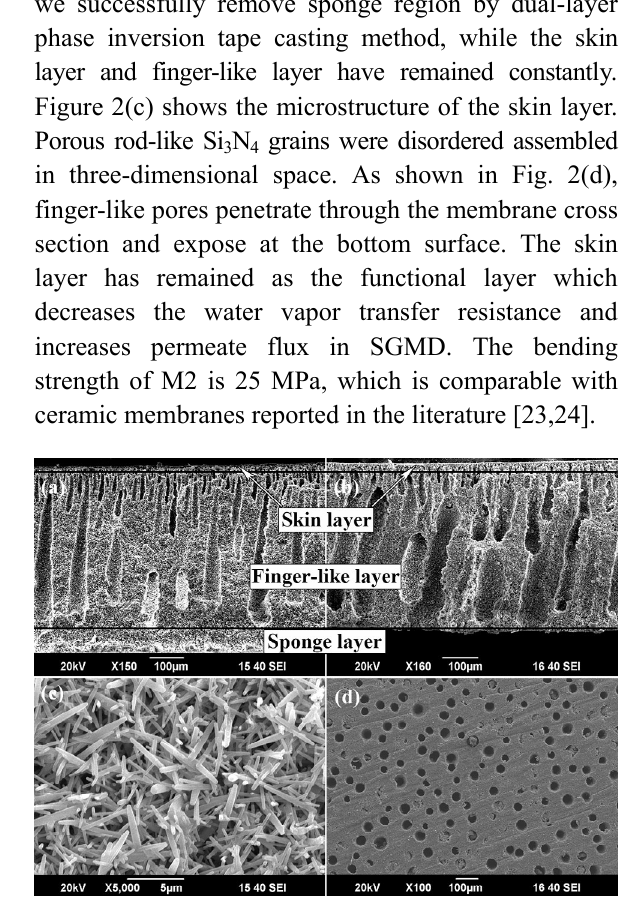
Fig. 2 Microstructure of the membrane: (a) cross section of M1; (b) cross section of M2; (c) top surface structure of M2; (d) bottom surface structure of